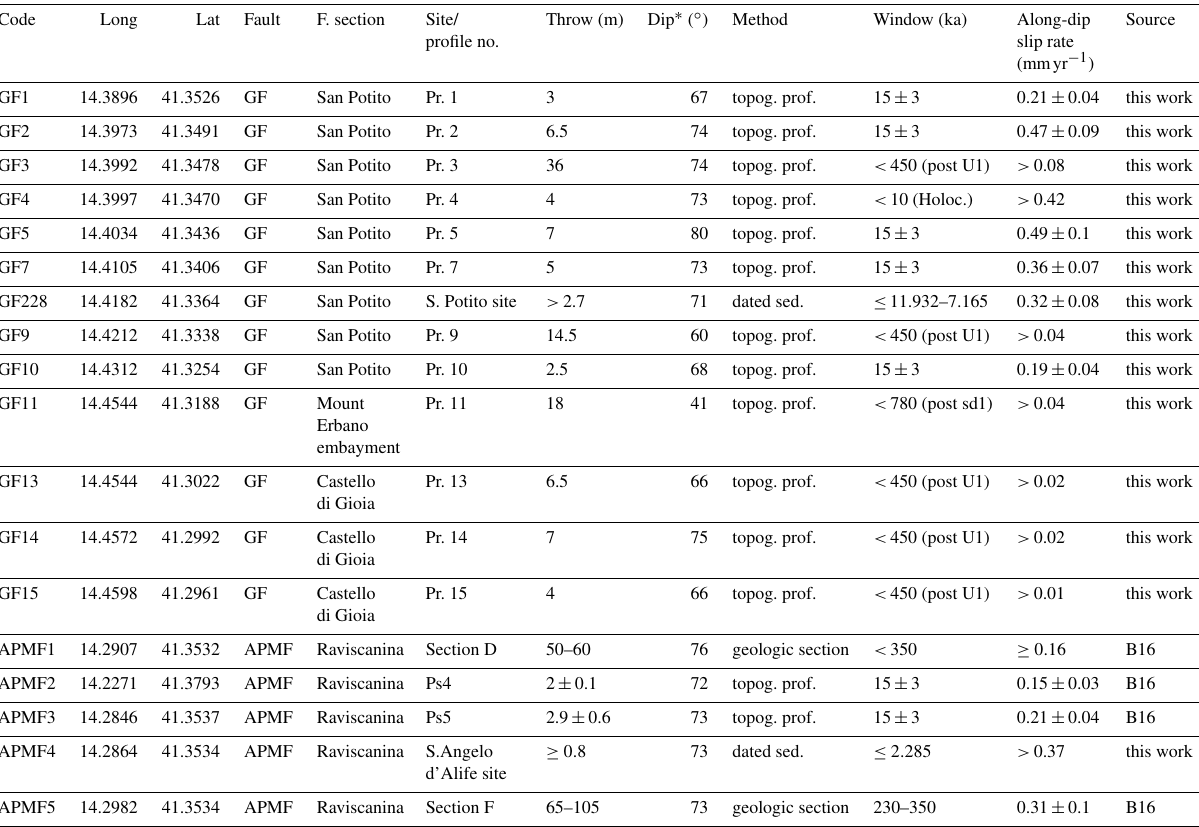
Table 3. Measured throw and slip rates along the Gioia Sannitica (GF) and Ailano–Piedimonte Matese (APMF) normal faults. Code Long Lat Fault F. section Site/ profile